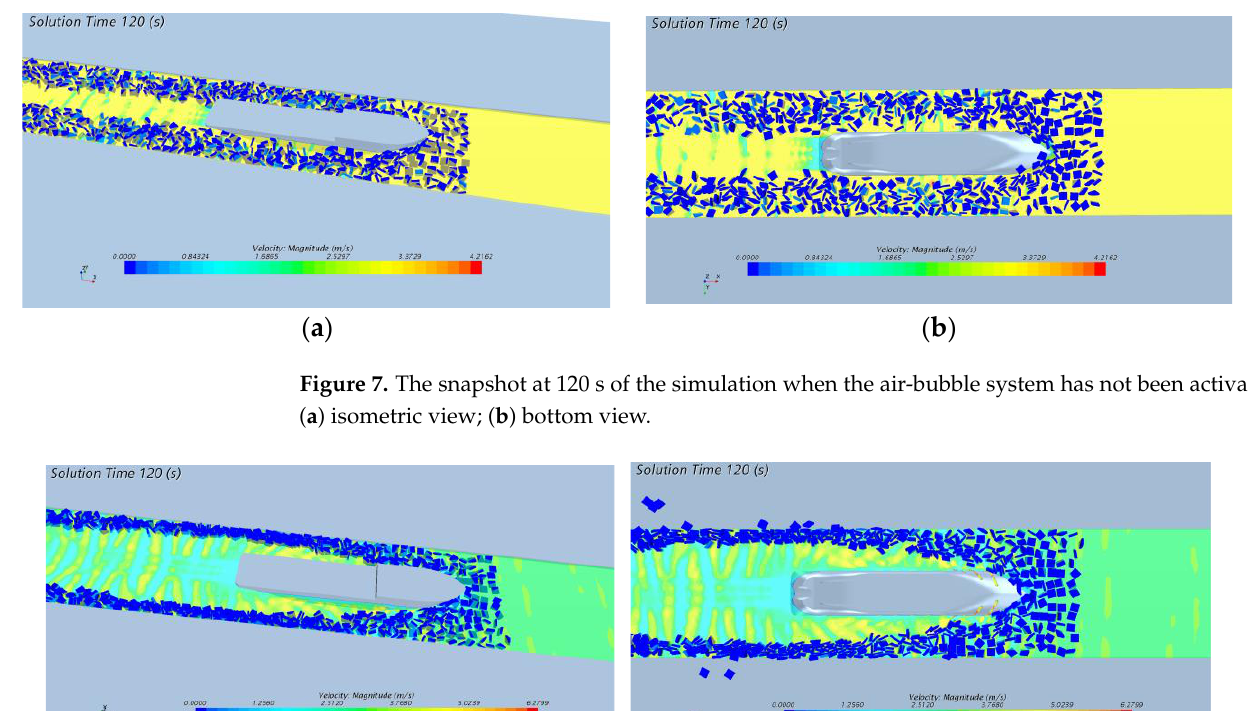
( b ) Figure 6. Wave patterns and streamlines around the hull for: ( a ) when the air-bubble system is turned off; ( b ) when the air-bubble system is activated. When ice exists in the water, additional resistance is induced by the interaction be- tween the hull and the ice floes. In this study, the ice fields are assumed to be composed of ice floes of identical size and shape of 4 m × 4 m × 1 m. The ice concentration is assumed to be 60%. Figure 7 illustrates the snapshot at 120 s of the simulation in the ice field with a ship speed of 6 knots. The air-bubble system has not been activated. When a ship enters